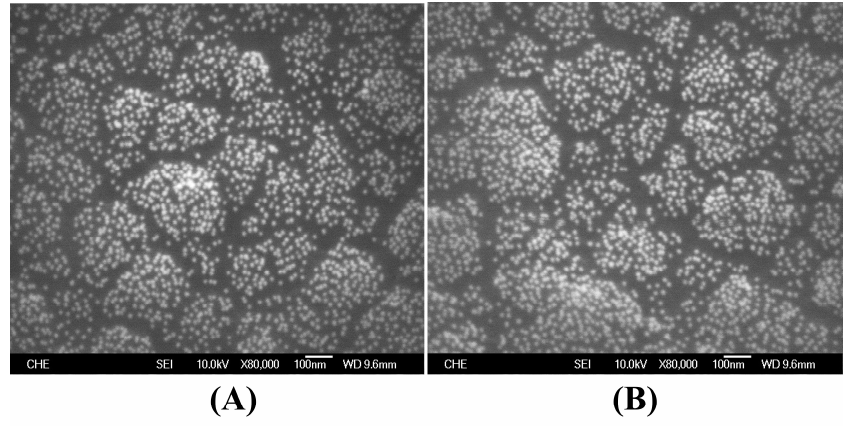
Figure 2. The images of SEM for the surface of AuNPs/PEDOT:BSA/Pt electrodes after being soaked in ( A ) distilled water, and ( B ) 3 M NaCl solution for two hours and air-dried.